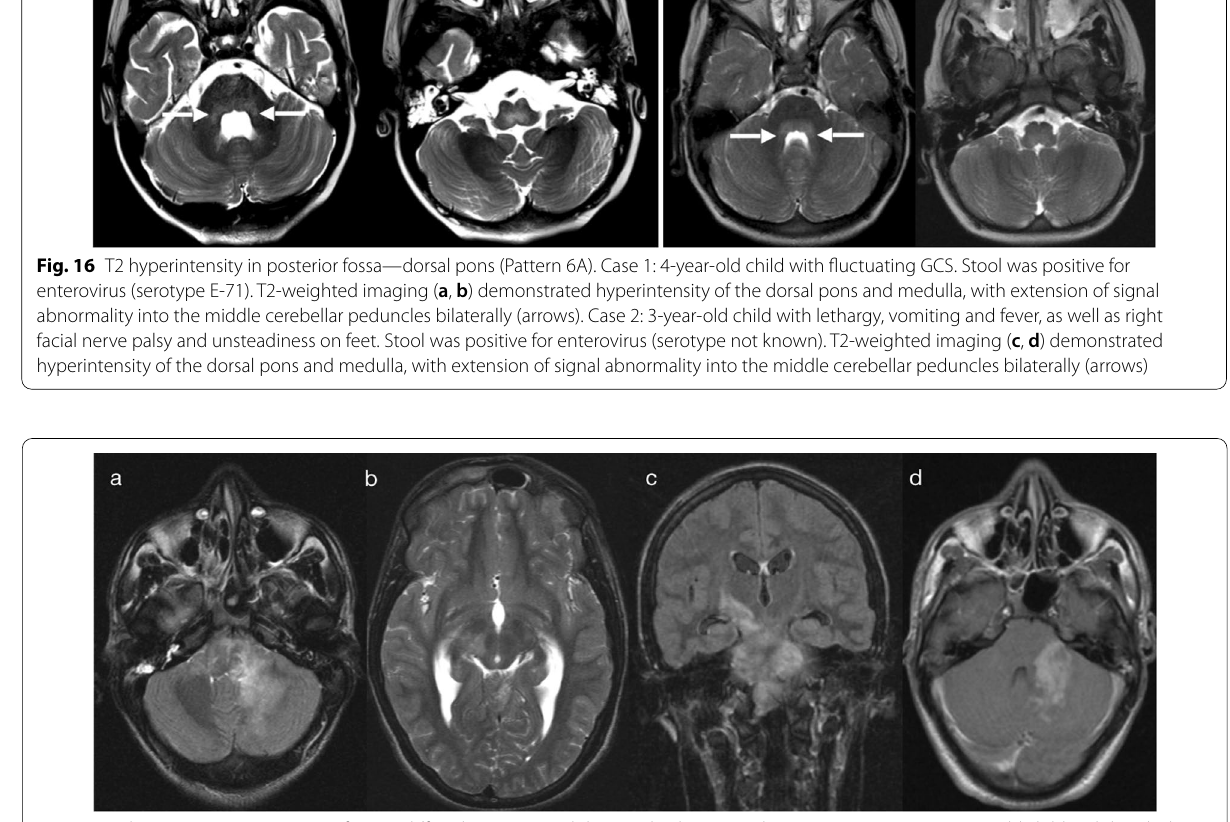
Fig. 17 T2 hyperintensity in posterior fossa—diffuse brainstem with longitudinal tract involvement (Pattern 6B). 14‑year‑old child with headache, vomiting, left cerebellar signs, left upper motor neuron facial palsy, diplopia and slurred speech. T2‑weighted images ( a , b ) demonstrated asymmetric T2 hyperintensity within the brainstem and left cerebellar hemisphere. Coronal FLAIR image ( c ) demonstrated extension of abnormality along white matter tracts to the contralateral supratentorial brain. Patchy enhancement was appreciable on post‑contrast T1‑weighted imaging ( d ). Minimal DWI change was seen (not shown). Neuromelioidosis was proved on brain tissue